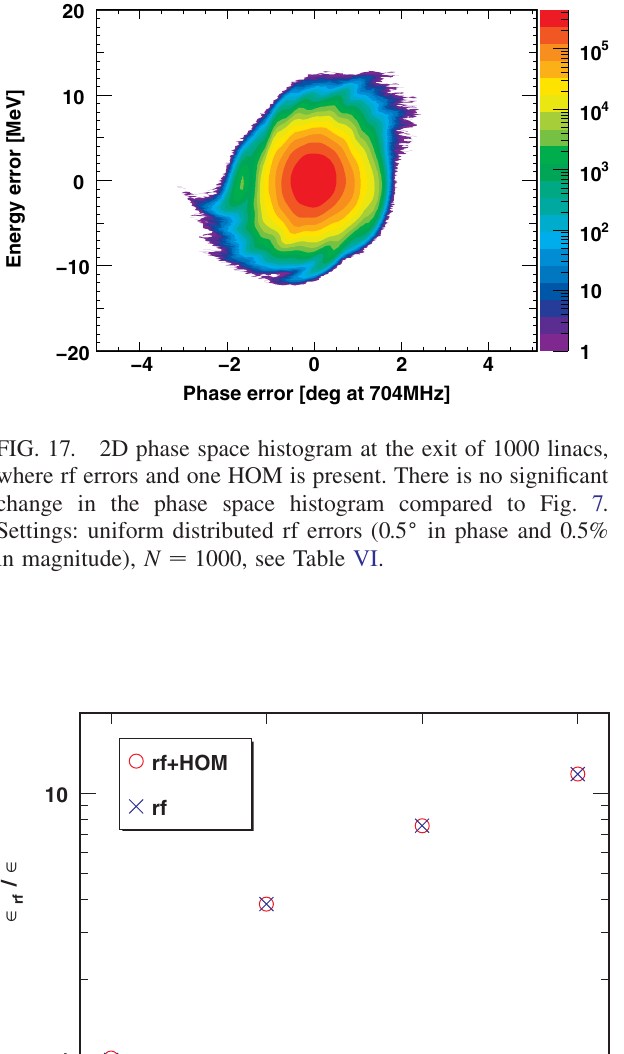
better illustrate the effect of a HOM at a machine line in combination with rf errors ( rf þ ML ), the following addi- tional cases are simulated: only a HOM at a machine line (ML), only rf errors (rf), and rf errors with a HOM not resonantly excited ( rf þ HOM ) are plotted together in Fig. 19. There the average and maximum values of 100 simulations per damping value are shown, where the HOM frequency pattern and the rf error pattern are both varied. An equal distributed RMS rf error of 0.5 (cid:8) in phase and 0.5% in amplitude is used in all simulations with rf errors.